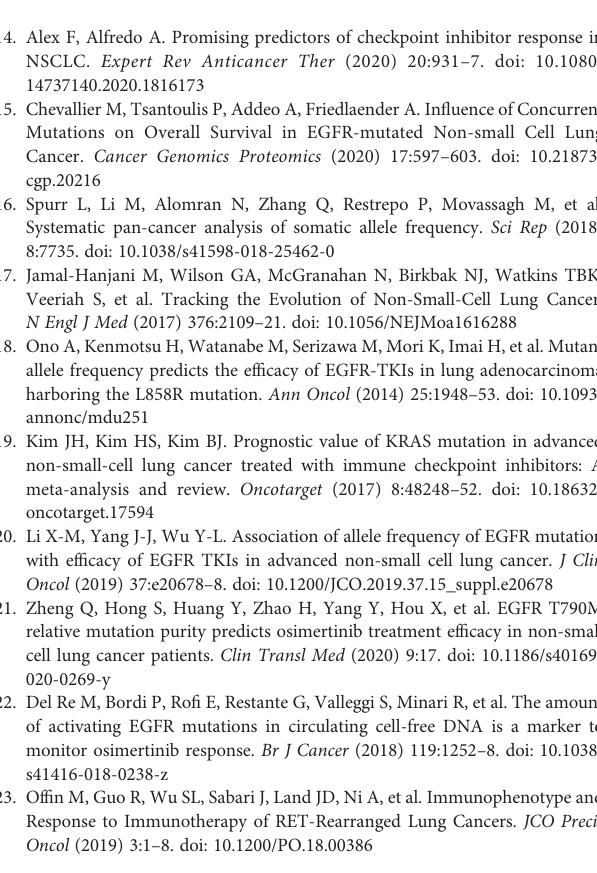
Supplementary Figure 1 | EGFR allelic frequency distribution density plot. Supplementary Figure 2 | Martingale